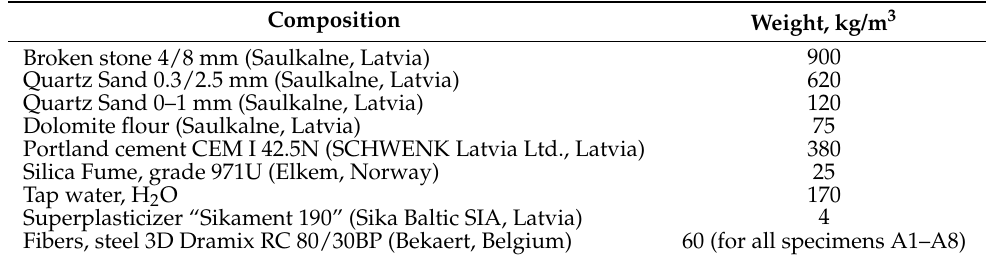
Table 2. Concrete mix